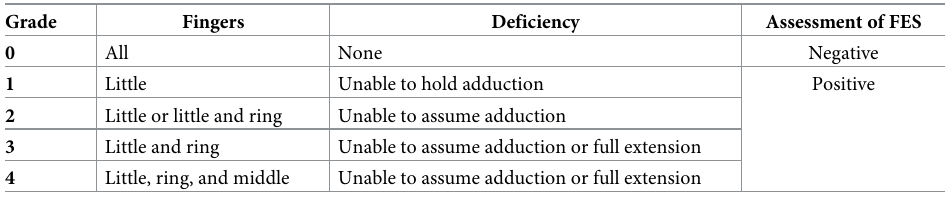
Table 4. Assessment of